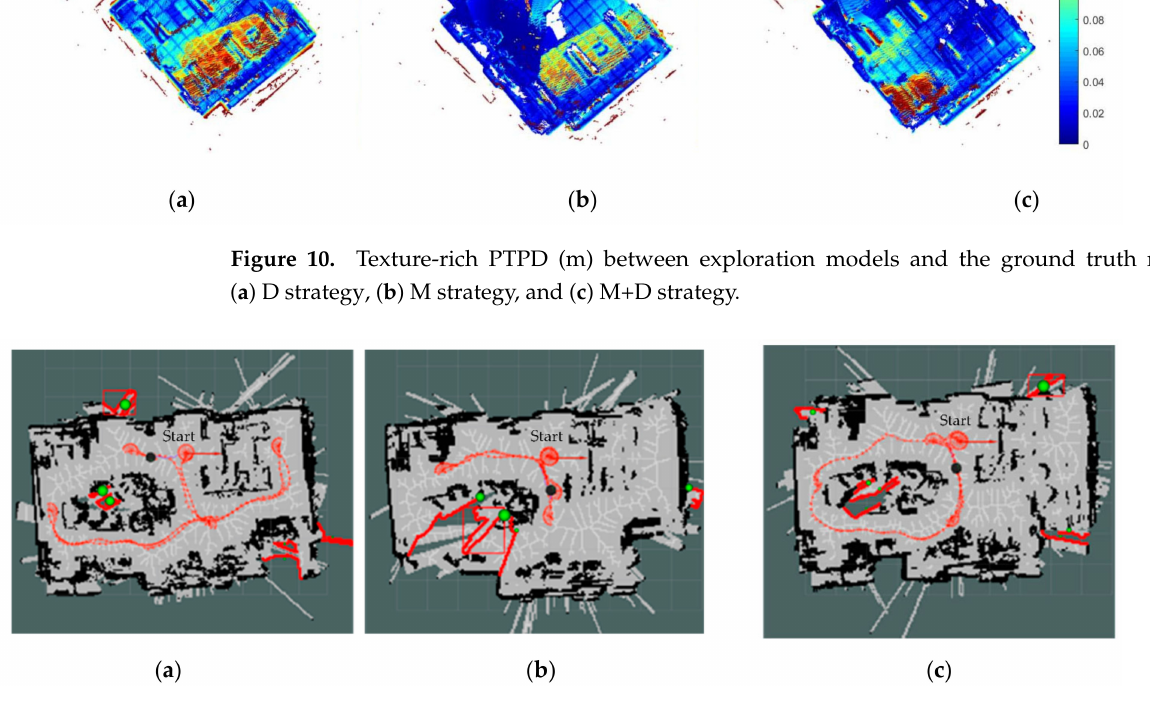
Figure 11. Exploration paths of the texture-rich environment, the bold red clusters are the ignored inaccessible frontiers, and the green balls represent the centroids of the frontiers. ( a ) D strategy, ( b ) M strategy, and ( c ) M+D